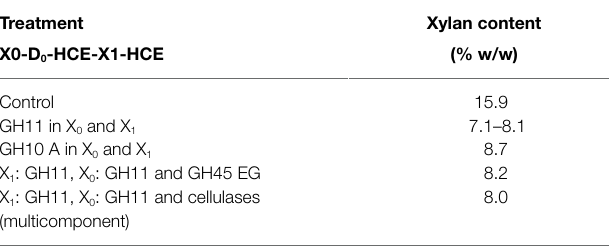
TABLE 3 | Combinations of enzymes applied in the X 1 stage tested at various temperatures, with 1% pulp consistency, followed by an alkaline extraction stage (E stage) applied to the X 0 -D 0 -HCE-treated pulp.